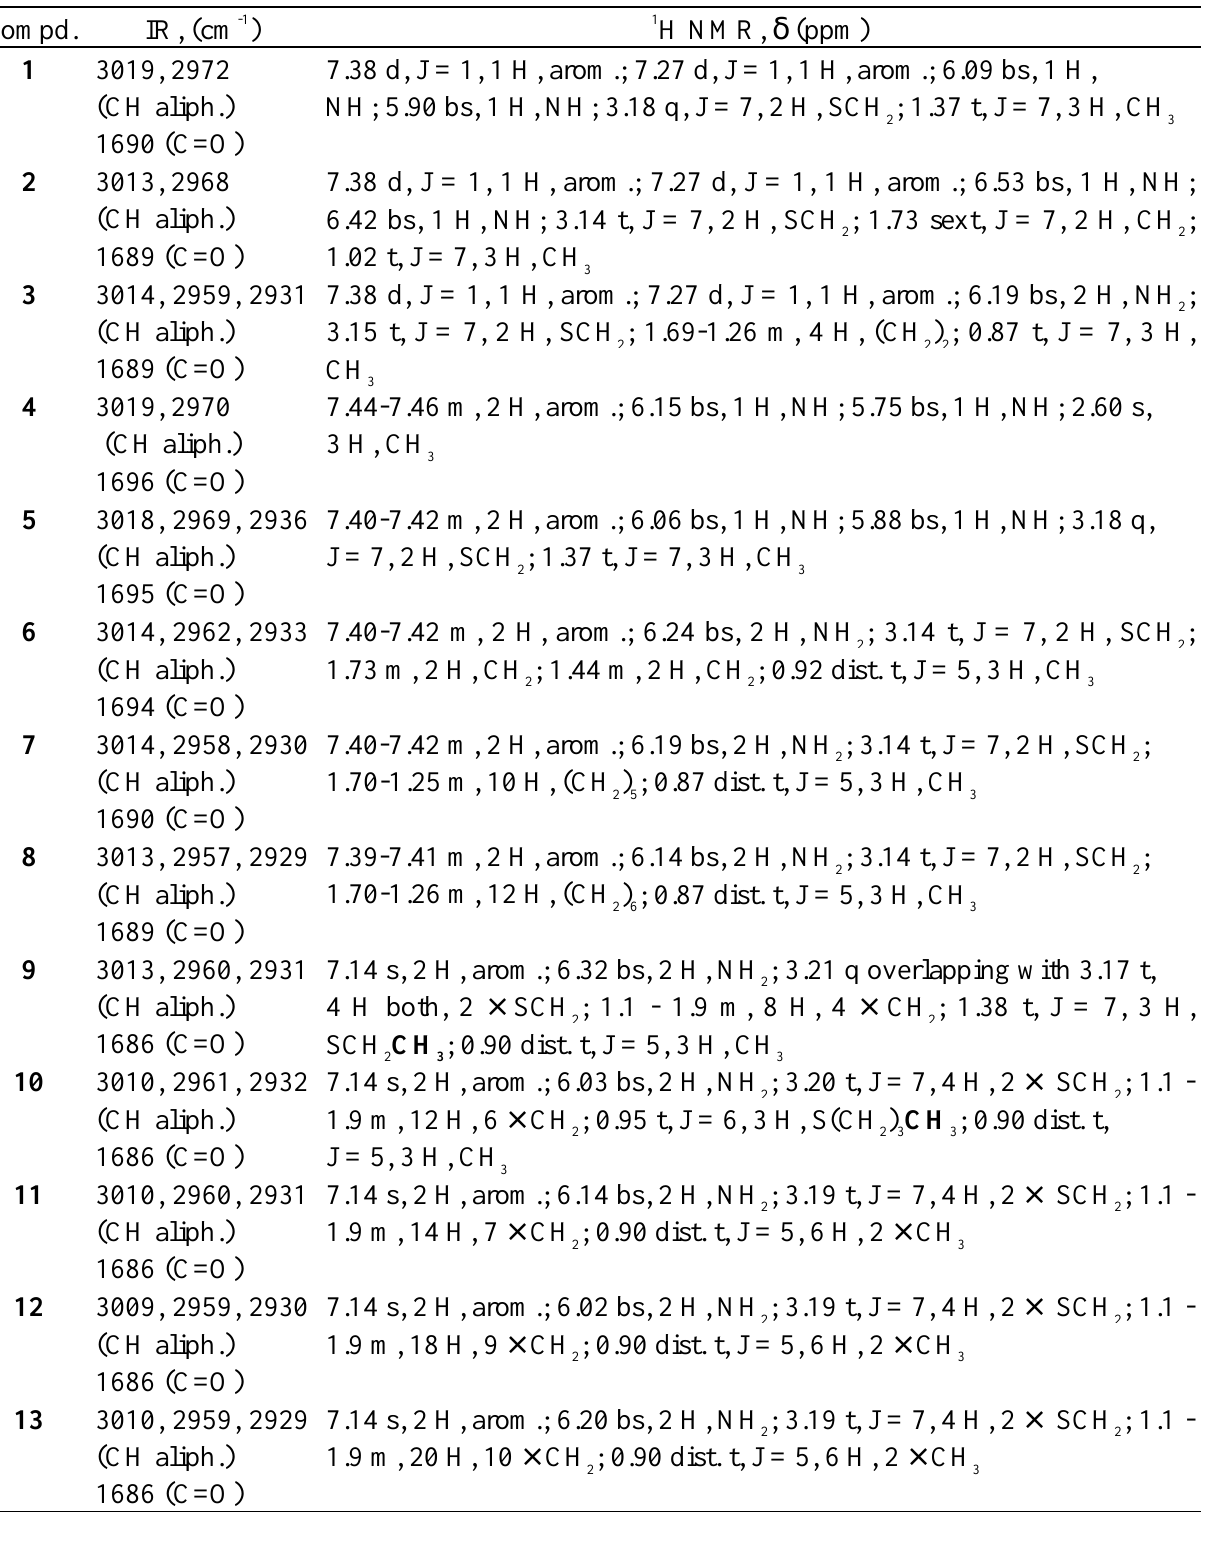
Table 2. IR and 1 H NMR spectroscopic data of the prepared compounds.